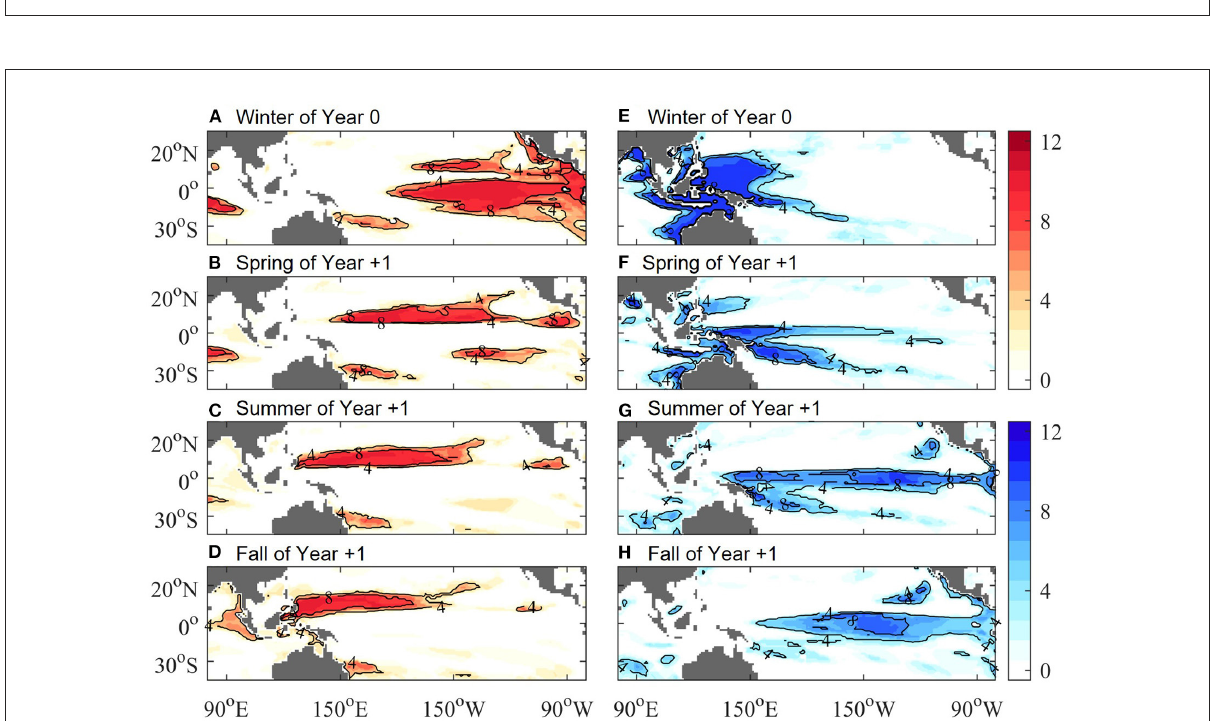
FIGURE15 Numbers of ensemble members of the CNRM-CM5 model with significant positive correlations between the WEP SZWA in fall and the tropical Indo-Pacific Oceans SSHA in (A) winter of Year + 0, (B) spring of Year + 1, (C) summer of Year + 1, and (D) fall of Year + 1. (E–H) are same as (A–D) , but for significant negative